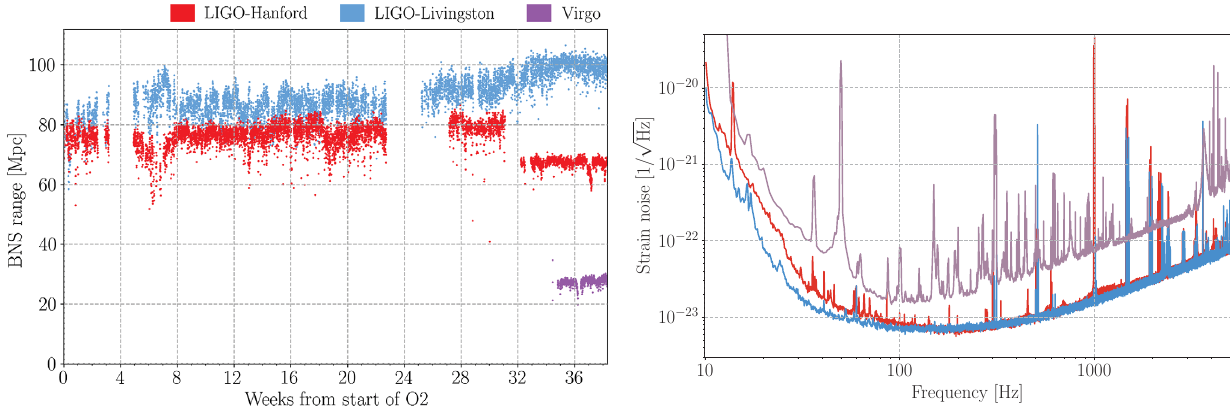
FIG. 1. Left: BNS range for each instrument during O 2 . The break at week 3 is for the 2016 end-of-year holidays. There is an additional break in the run at week 23 to make improvements to instrument sensitivity. The Montana earthquake ’ s impact on the LHO instrument sensitivity can be seen at week 31. Virgo joins O 2 in week 34. Right: Amplitude spectral density of the total strain noise of the Virgo, LHO, and LLO detectors. The curves are representative of the best performance of each detector during O 2